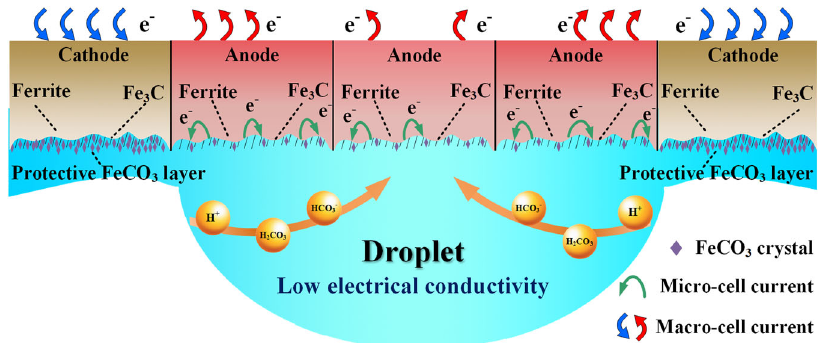
Fig. 10 Schematic diagram of TLC at the test condition. The mechanistic model of the distribution of the corrosion products and the formation of macro-cell